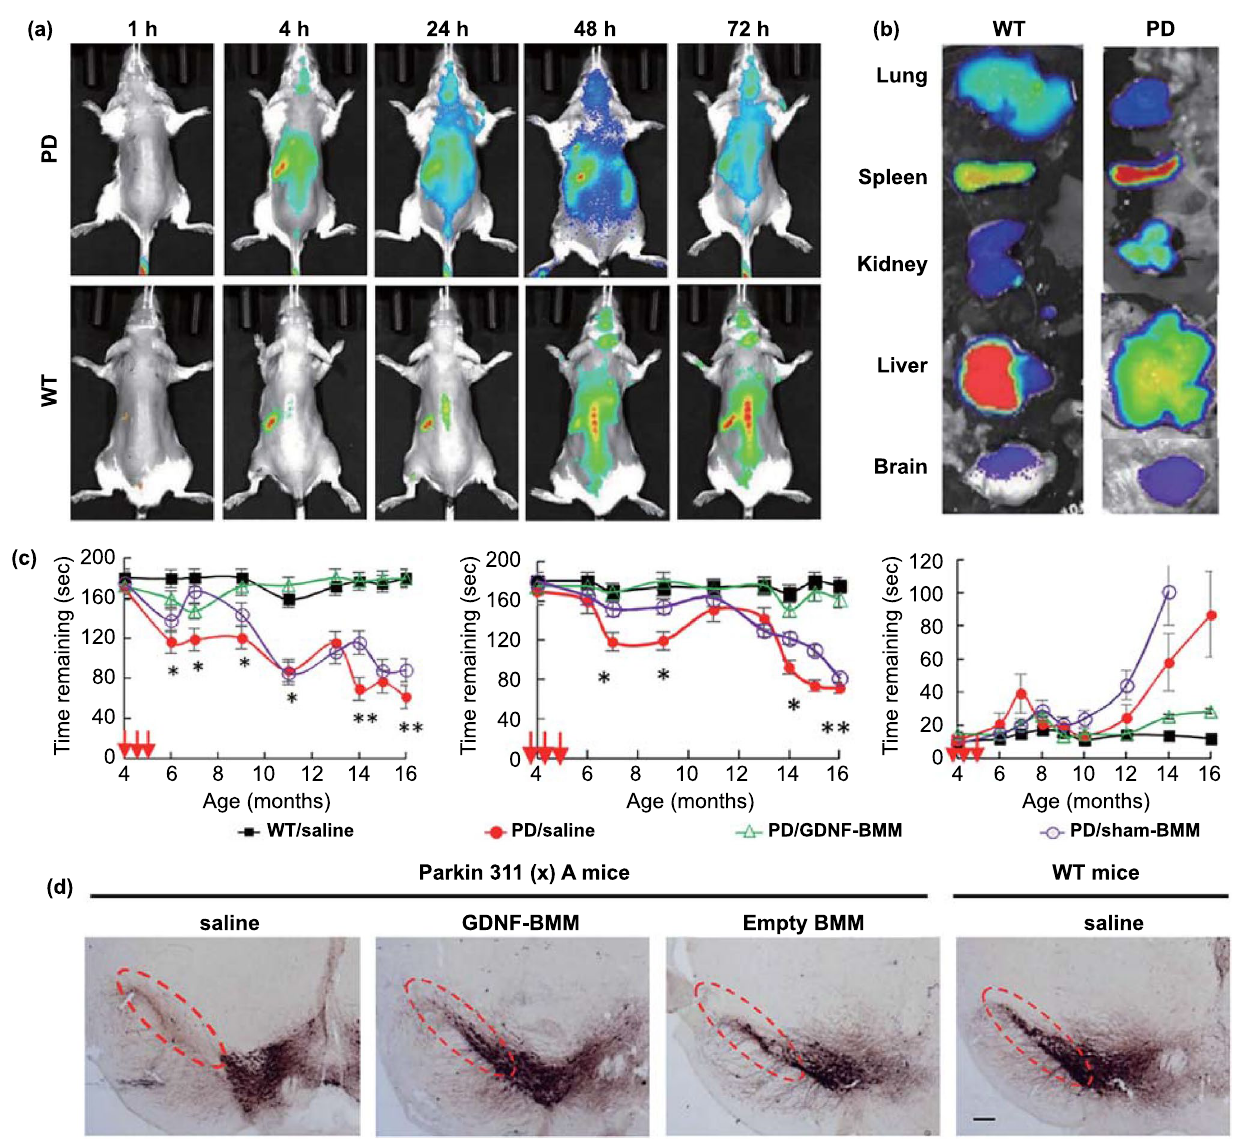
Fig. 6 Biomimetic-delivery strategy for BBB crossing. a Parkin Q311(X)A mice (4 Mo. of age) were i.v. injected with 6 × 10 6 DIR-mac- rophages and imaged using IVIS. b At the end point (72 h), mice were sacrificed, and perfused; the main organs were removed, and images were obtained using IVIS. c Behavioral tests demonstrating the preservation of locomotory function in Parkin Q311(X) mice upon treatment with GDNF-macrophages at an early stage of disease. d GDNF-BMM could protect dopaminergic neurons in Parkin Q311(X)A mice. Adapted from Ref.